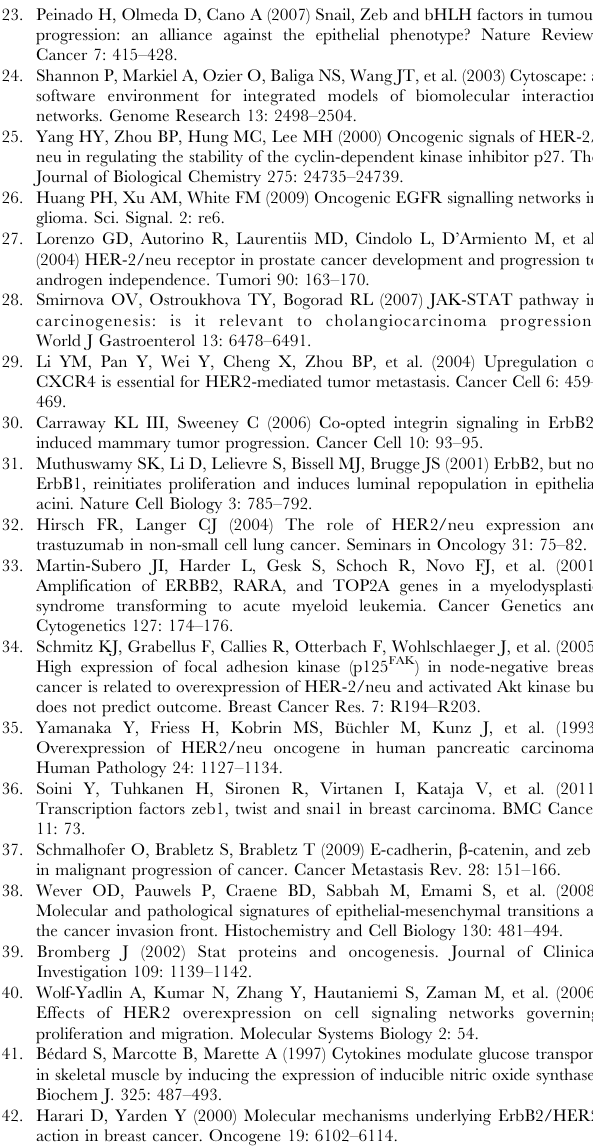
Table S3 All the significantly enriched KEGG pathways with respect to the union deregulated module generated by Backes’ method. The table lists the results of ORA on the union deregulated module generated by Backes’ method [5]. The significance p-values are calculated using the FDR adjustment